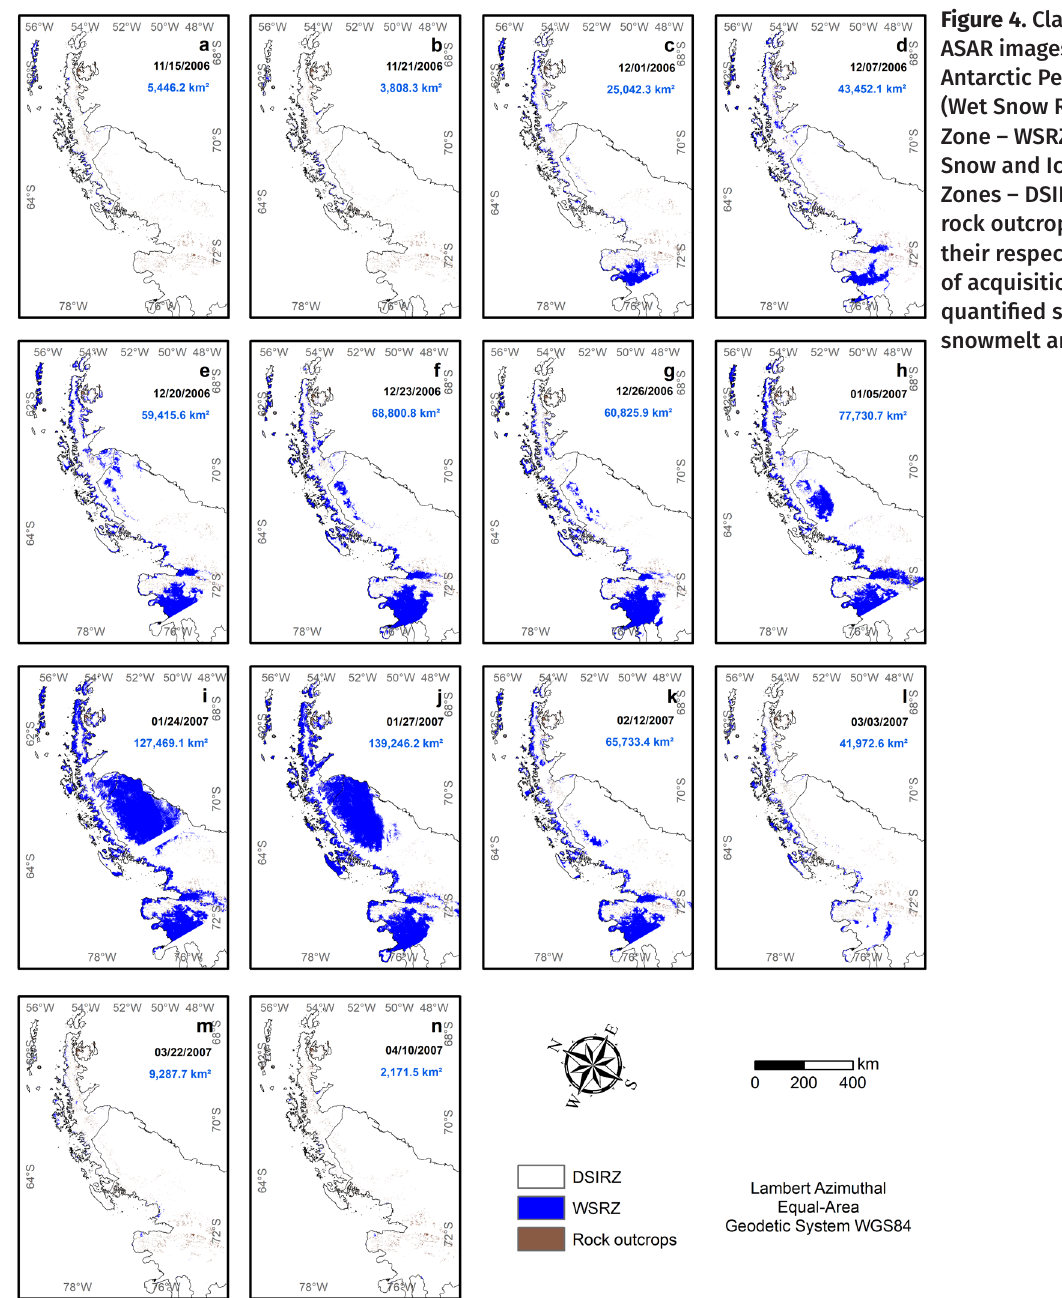
ASAR images of the Antarctic Peninsula (Wet Snow Radar Zone – WSRZ; Dry Snow and Ice Radar Zones – DSIRZ; and rock outcrops), with their respective dates of acquisition and quantified superficial snowmelt areas